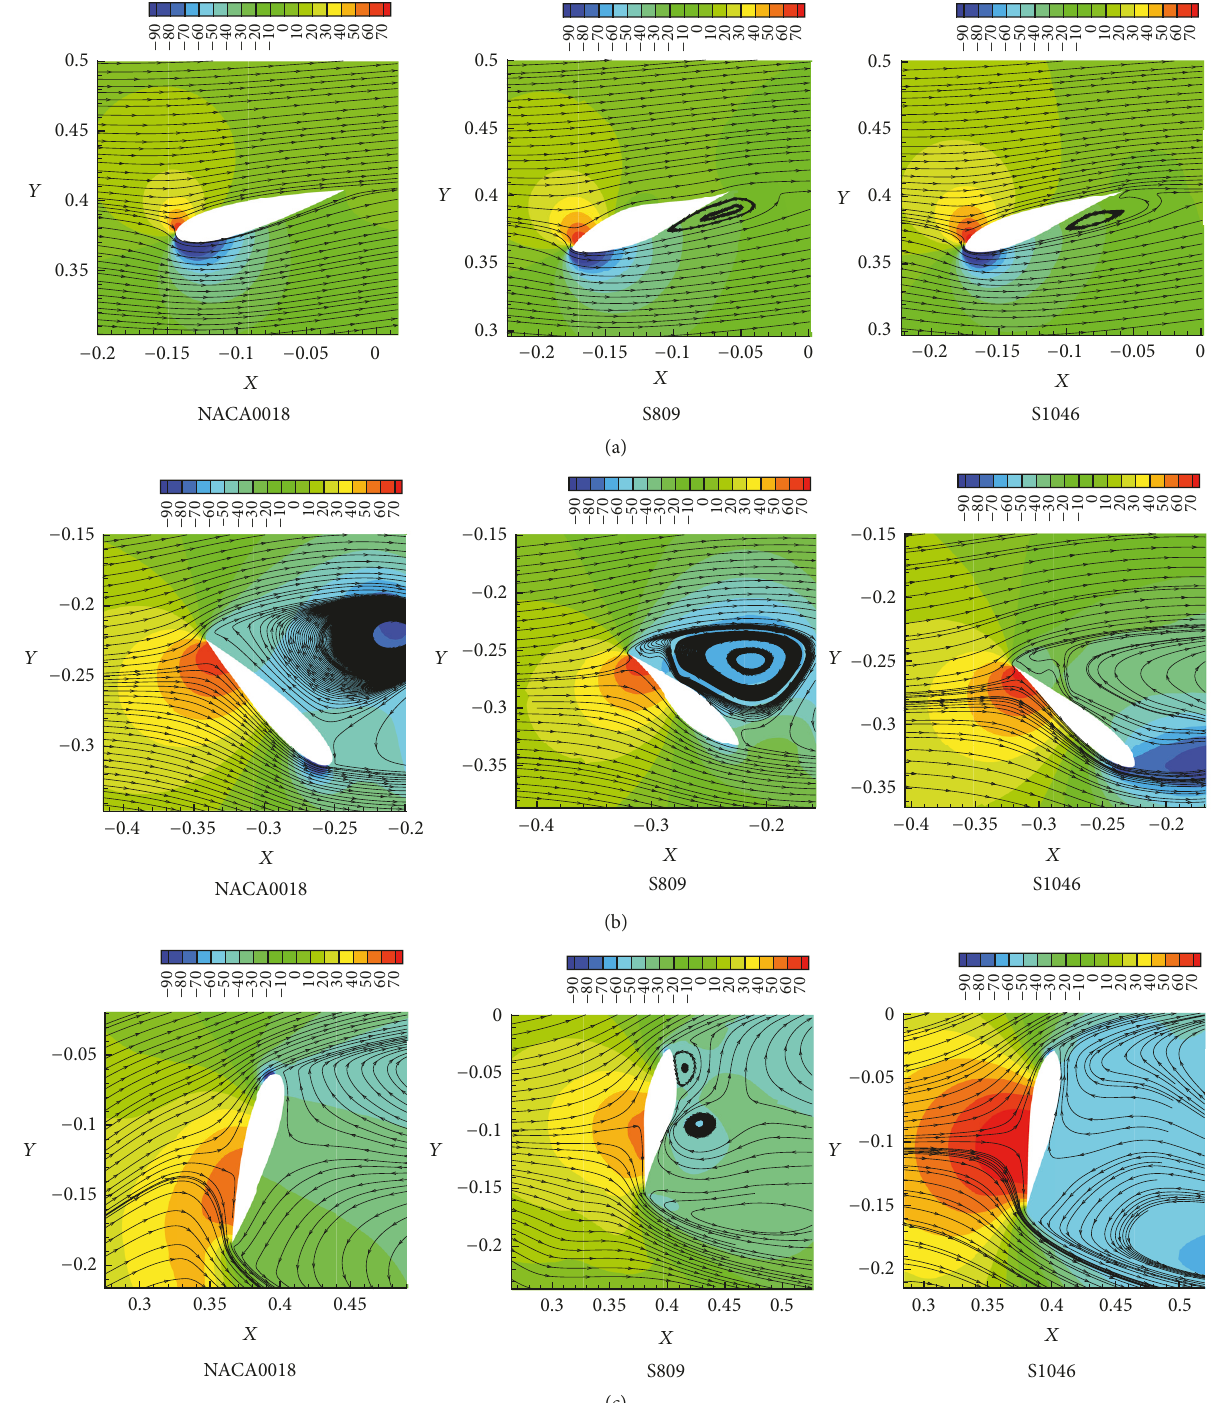
Figure 15: Flow fields around blade with different